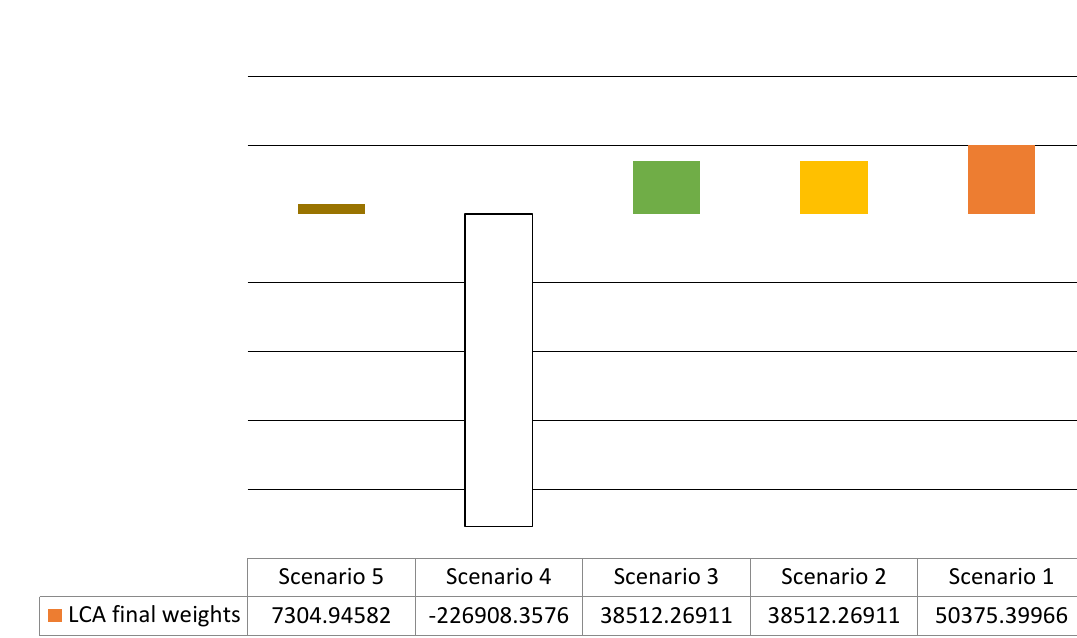
Figure 3 . Scenario's final